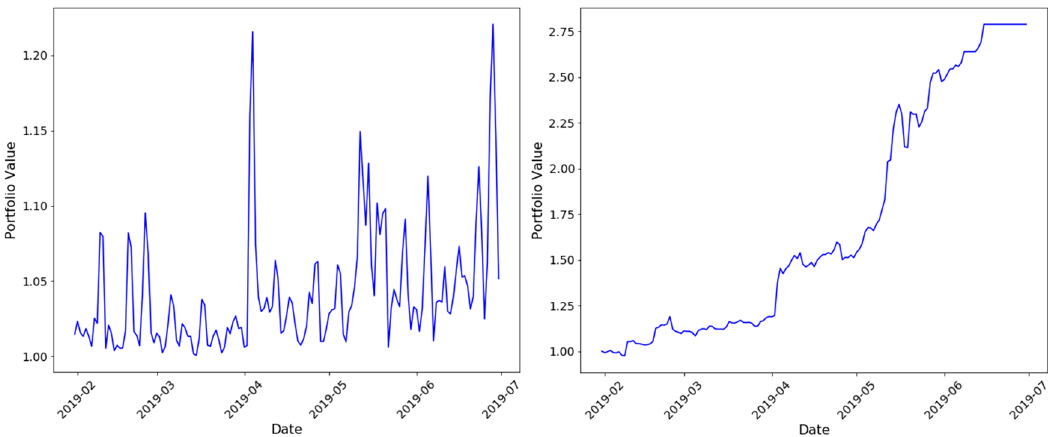
Figure 6. Bitcoin price as predicted by the GRU one-layer model with dropout and recurrent dropout.